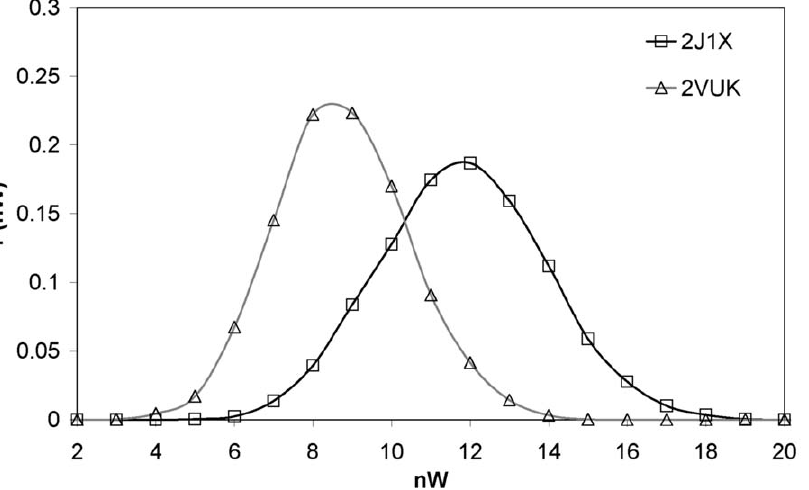
Figure 3. Distribution of the number of water molecules within the desolvation domain of the HB CYS 220 - THR 155. Pdbs 2VUK (T- p53C-Y220C-PhiKan083; m =8.743 and s =1.720) and 2J1X (T-p53C-Y220C; m =11.819 and s =2.111).